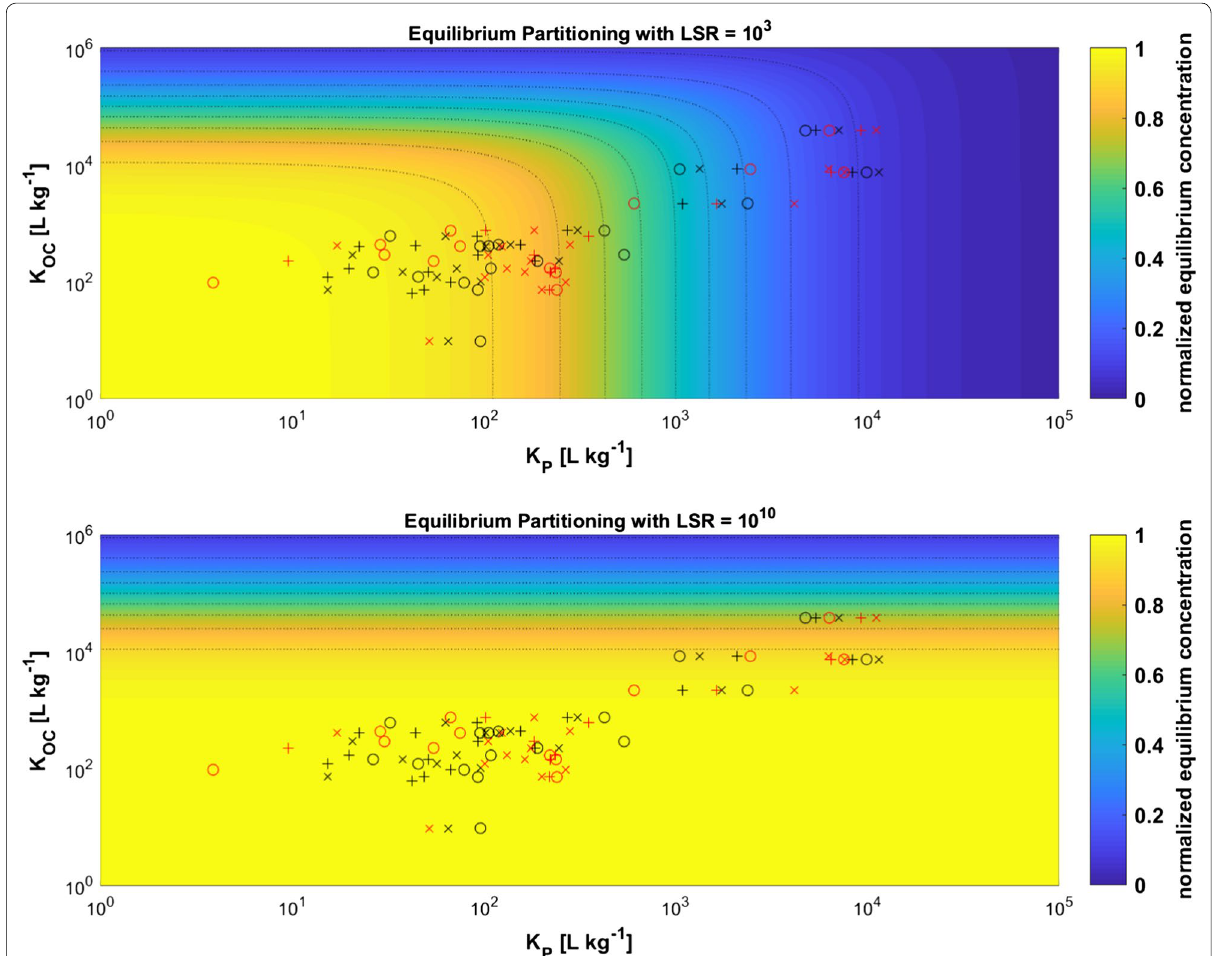
Fig. 4 Equilibrium distribution map for a freshwater system with natural particles (organic carbon) and microplastic particles under two different concentration scenarios. Experimental conditions (plastic LSR 10 3 L kg − 1 , Scenario I) are shown in the top panel and environmental conditions = (plastic LSR 10 10 L kg − 1 , Scenario II) in the bottom panel. Crosses, circles, and pluses show the aqueous equilibrium concentrations at pH 4, pH = 7, and pH 10, respectively, in µg L − 1 calculated with the experimentally determined D P for PE (black symbols) and for PS (red symbols) and the investigated substances. For both cases, a constant concentration of 10 − 5 kg L − 1 OC was assumed. K OC values were estimated using EPISuite